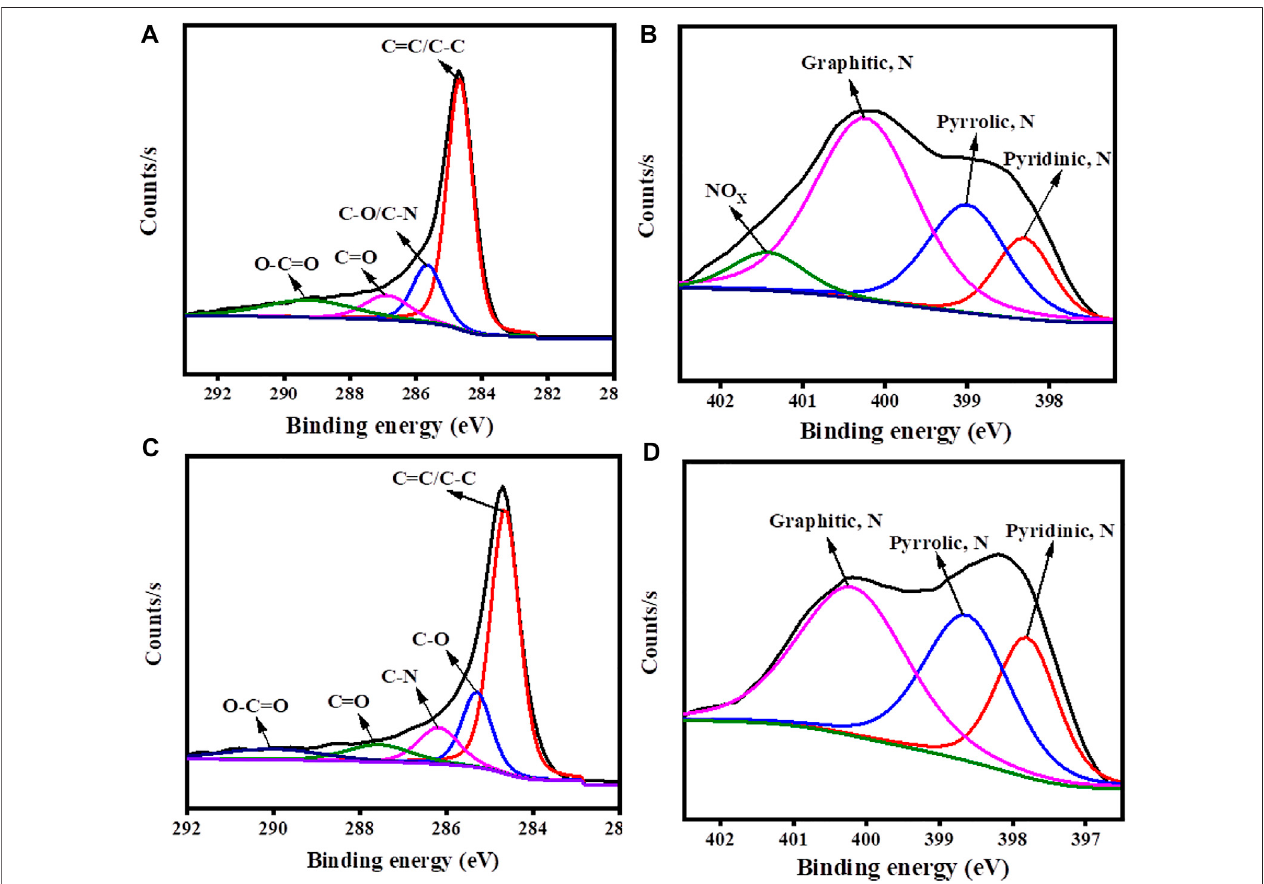
FIGURE 7 | C1s, N1s deconvoluted XPS spectrum of (A,B) c-2CzPN – KOH and (C,D) c-4CzPN – KOH.